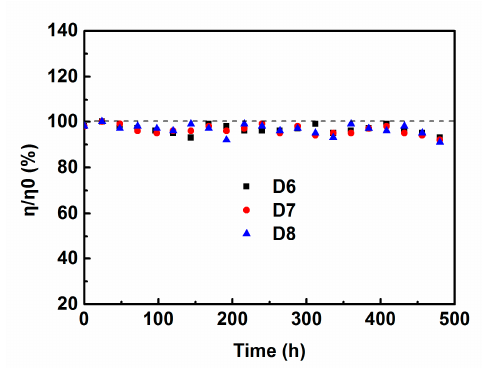
Figure 7. The long-term stability of DSSCs based on the dyes.